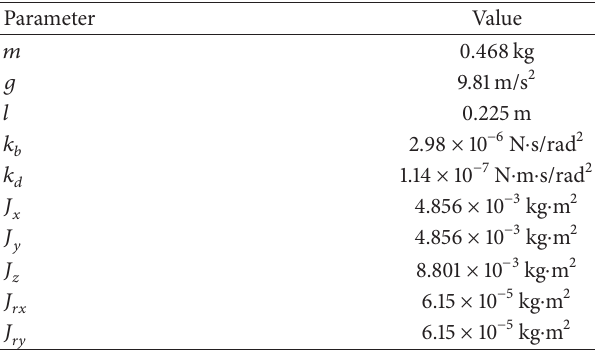
Table 1: Quad-rotor parameters in